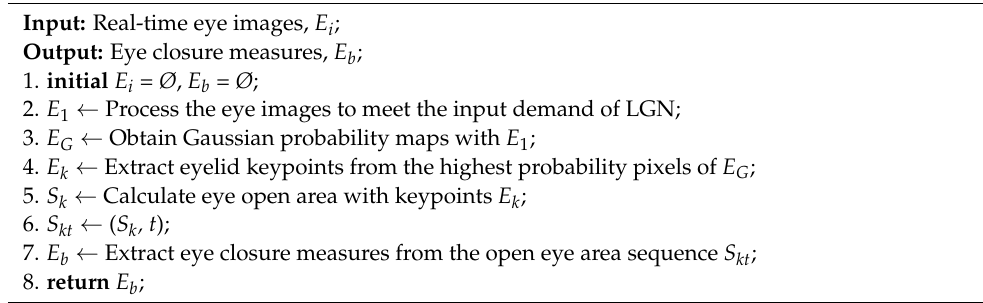
Algorithm 1 The Workflow of Our Glass